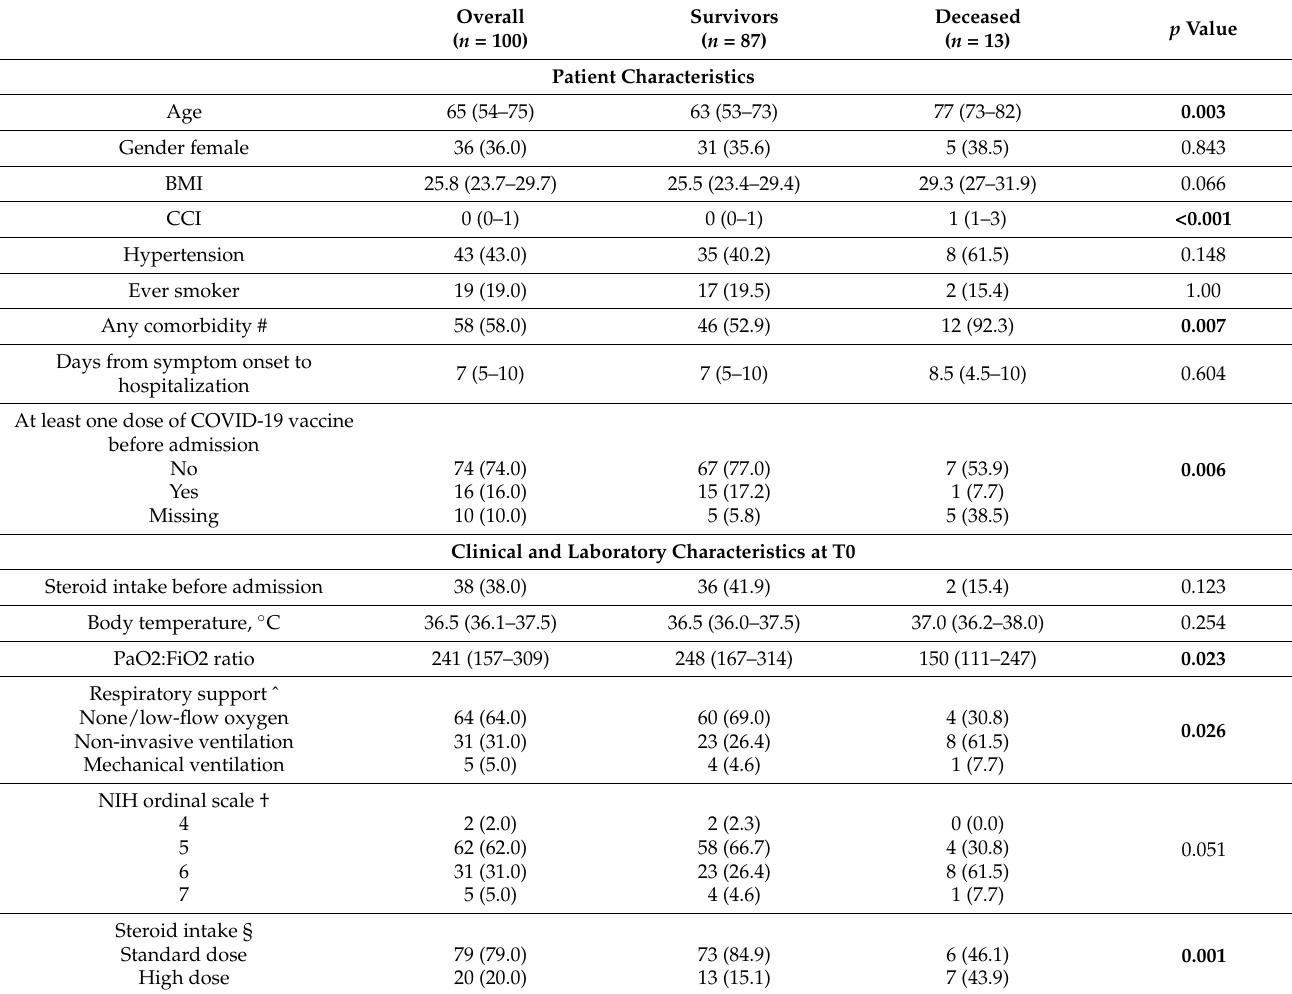
Table 1. Clinical and laboratory characteristics at enrollment (T0) and after 7 days (T1), overall and for survivors and